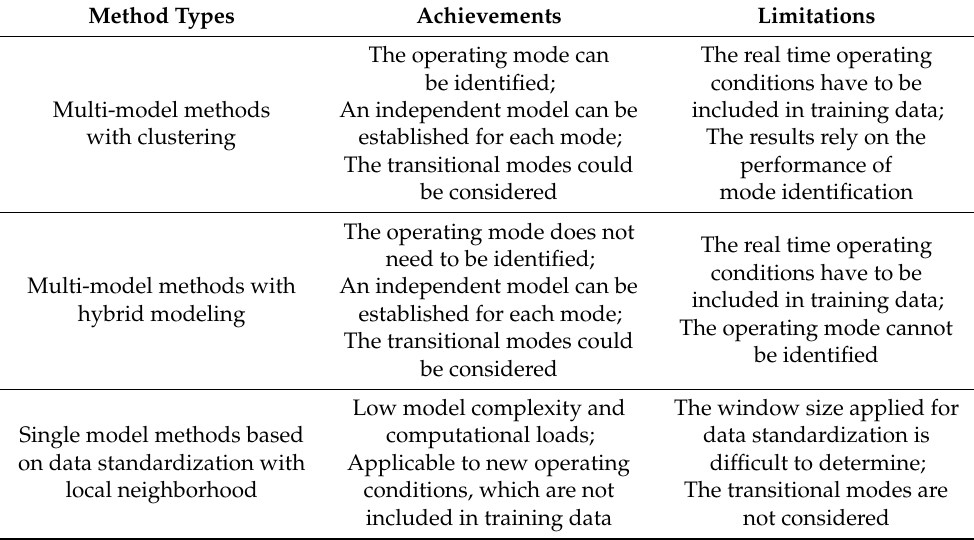
Table 7. Comparative analysis of multimode process monitoring